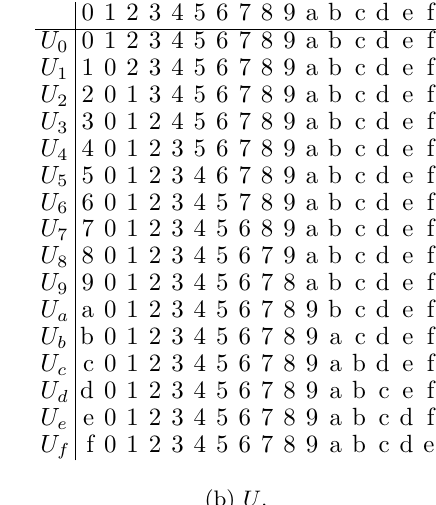
Table 7: The mini-block ciphers from the TU-decomposition of 𝒫 .